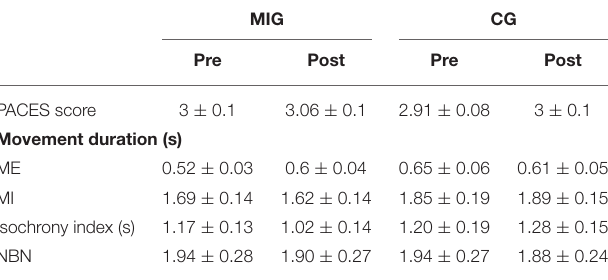
TABLE 1 | Mean values ( ± standard error) of parameters used to evaluate changes before (PRE) and after (POST) the training in the motor imagery group (MIG), who added motor imagery (MI) to movement execution (ME), and in the control group (CG), who performed only